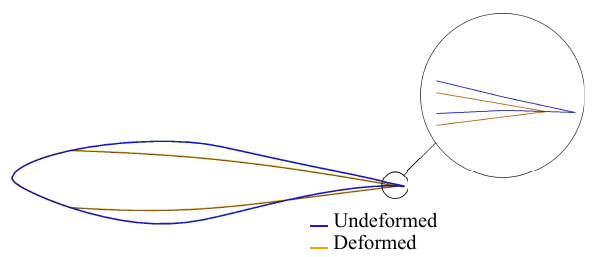
Figure 11. Form finding of the membrane blade (mid-span section, second segment from the root).